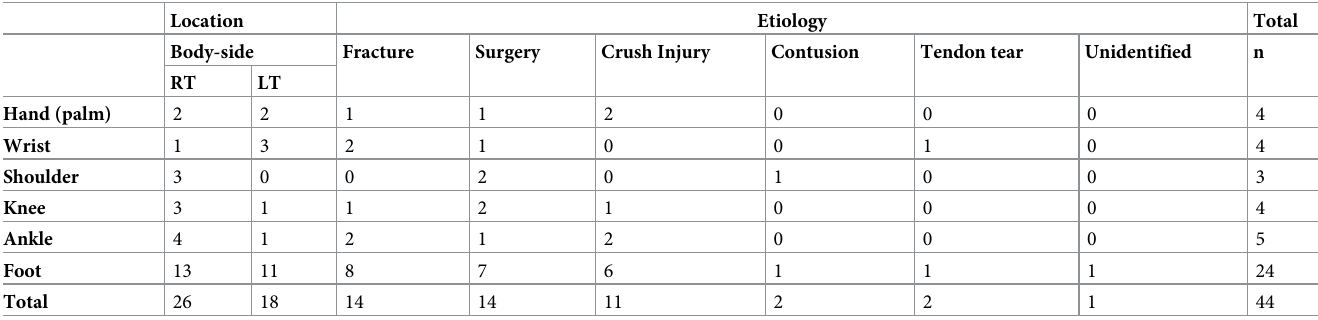
Table 1. CRPS site and etiology (N =